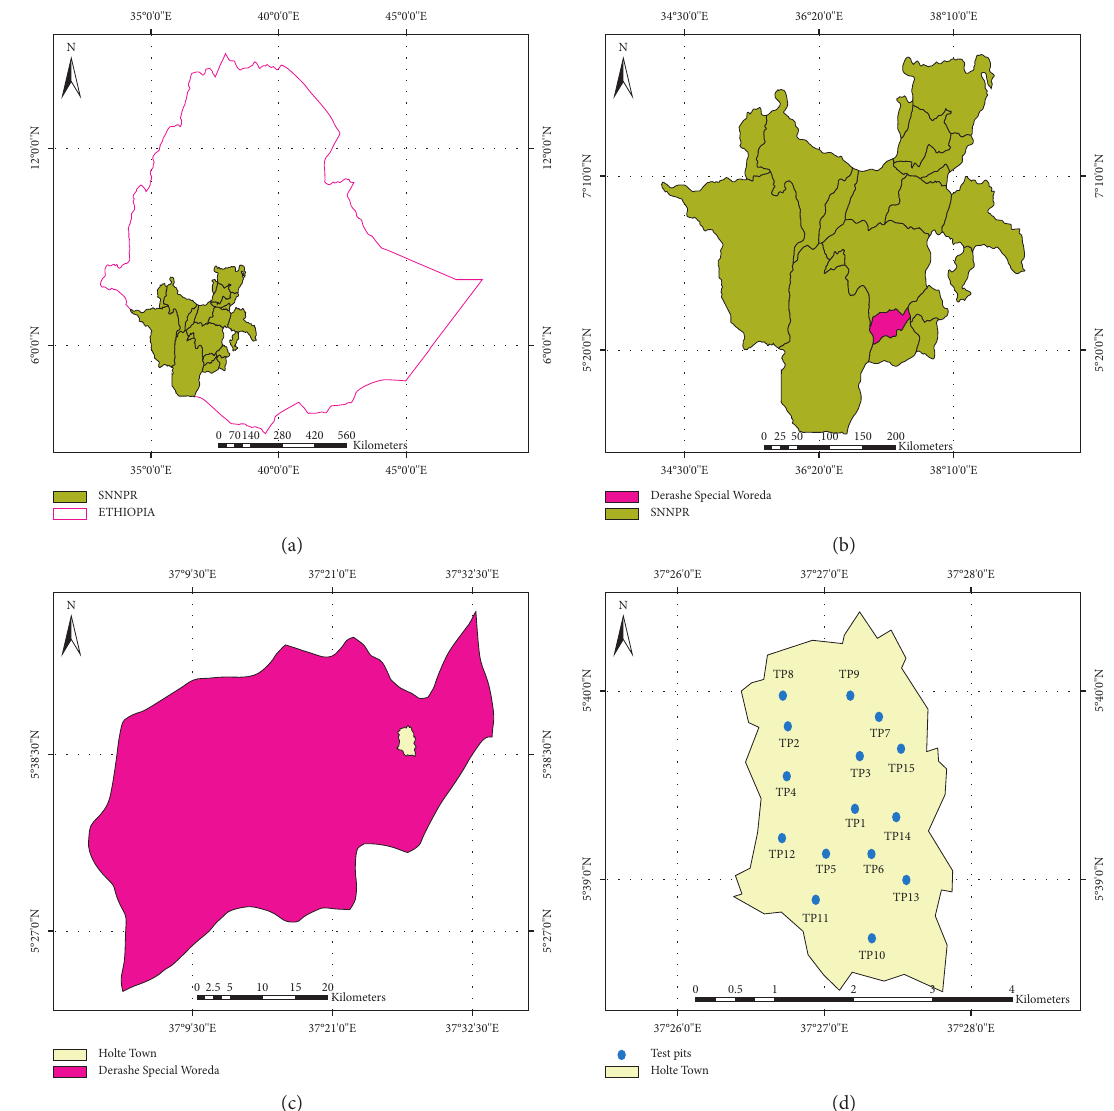
Figure 1: Map of (a) Ethiopia, (b) map of SNNPR, (c) Holte town, and (d) test pit